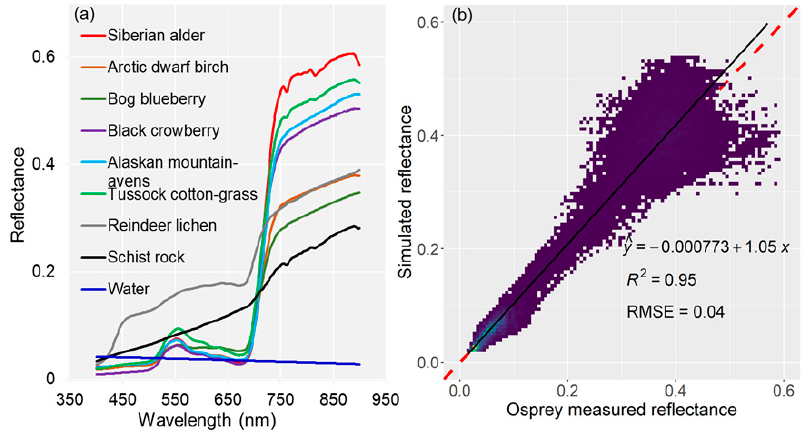
Figure 8. ( a ) The mean spectra of seven species components and two non-vegetation components used for the linear spectral simulation. ( b ) Scatter plot of the simulated footprint spectra reflectance data against the Osprey -collected spectral reflectance data (density of data points is shown with colormap).